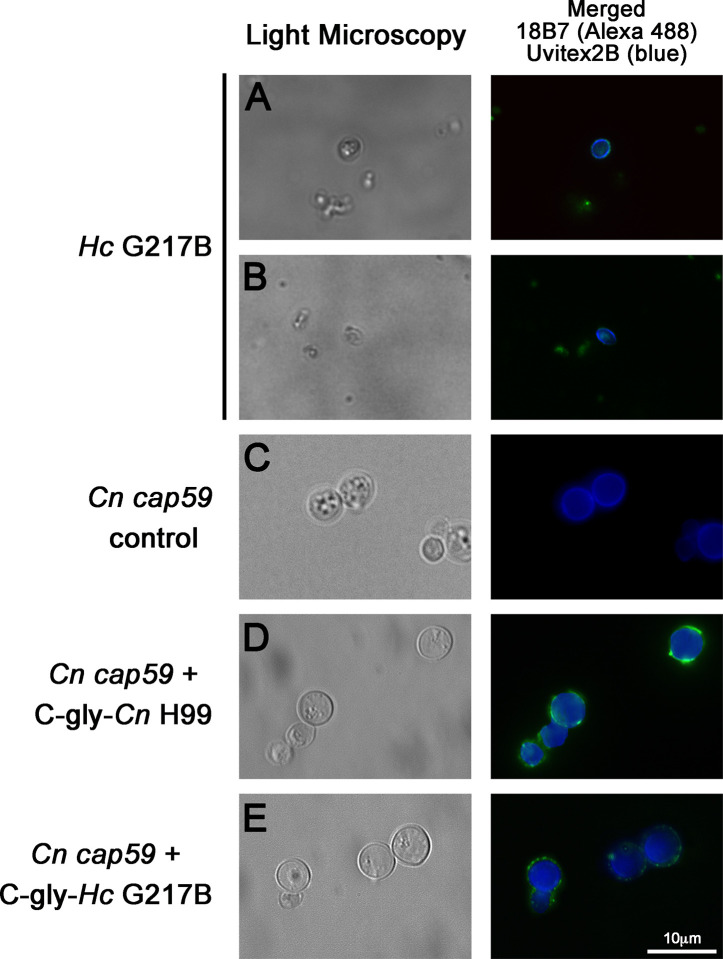
Glucuronoxylomannan (GXM) monoclonal antibodies (mAbs) bound to the C-gly on the H. capsulatum yeast surface, and these extracted glycans are promptly incorporated by acapsular mutants of C. neoformans.
(A, B) The 18B7 mAb to C. neoformans GXM bound C-gly-Hc on the surface of the H. capsulatum (Hc) yeast, with labeling ranging from a (A) punctuated to a (B) ring pattern. (C–E) Acapsular C. neoformans cap59 (Cn cap59) mutants were used in glycans incorporation. (C)
Cn cap59 incubated with PBS as negative control did not display binding by 18B7 mAb. (D) Incubations of Cn cap59 with C-gly-Cn H99 used as a positive control did not result in capsular structure visible by light microscopy, but surface incorporation was detected by binding of the 18B7 mAb through immunofluorescence. (E)
Cn cap59 incubation with C-gly-Hc resulted in a similar pattern to C-gly-Cn, suggesting conserved anchoring mechanisms of glycans from distinct origin. Pictures were taken with an 100X objective magnification. Scale bar = 10 µm.